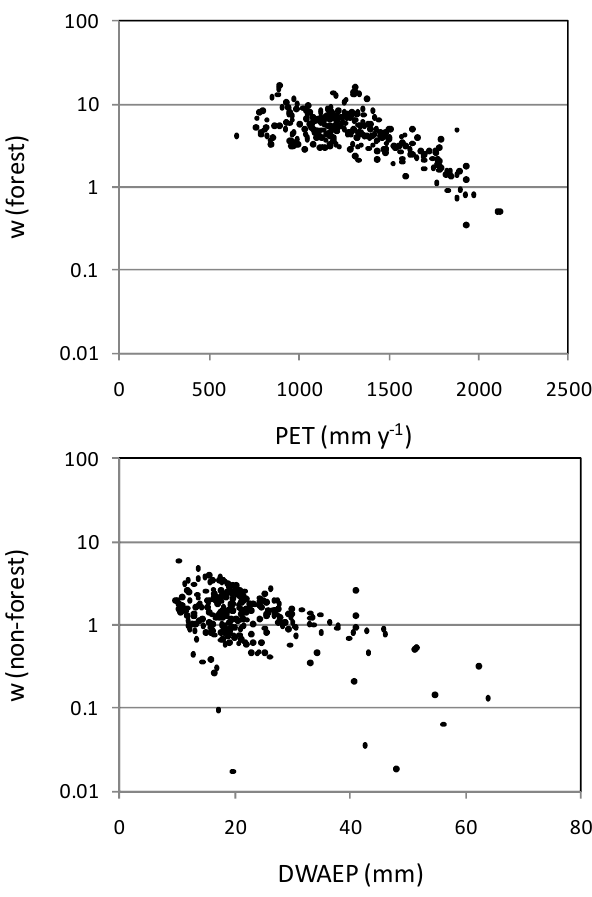
Fig. 3. Relationship between the catchment variable that explained most of the variance in (log-transformed) Zhang model parameter ( w) values inferred from the synthetic land cover experiment, (top panel) potential evaporation (PE) for forest catchments and (bottom panel) depth-weighted average event precipitation (DWAEP) for herbaceous catchments.